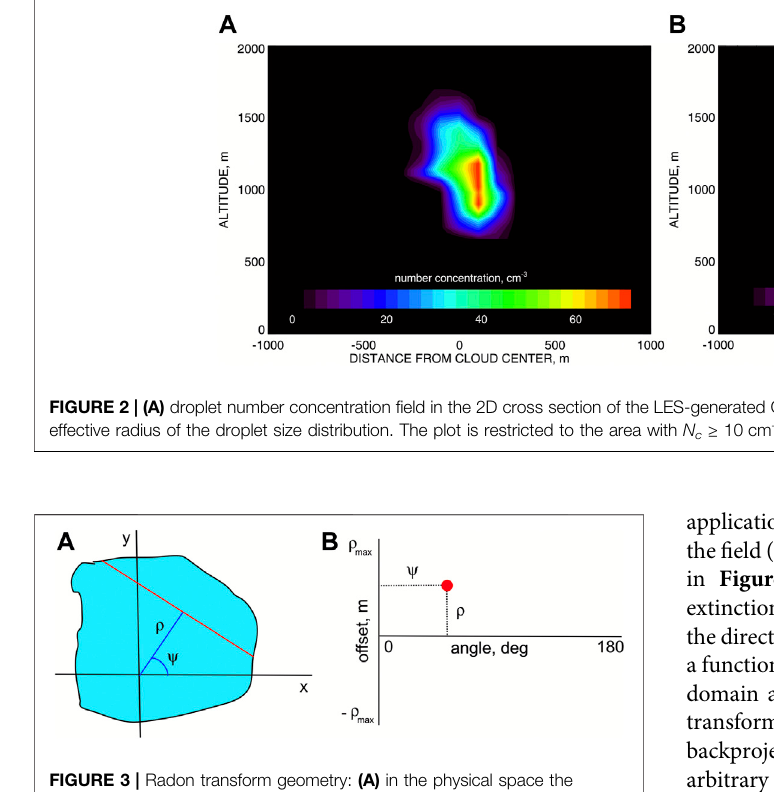
fi lter is a high pass fi lter with V-shaped kernel |f| in frequency